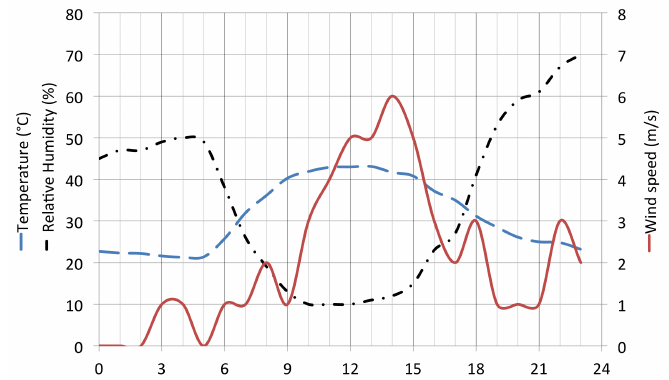
Figure 1. Sartene weather station records on 23 July 2009 (in hours UTC): temporal evolution of 10-m wind speed (in red, in ms − 1 ), 2-m temperature (in blue, in deg C) and relative humidity (in black, in